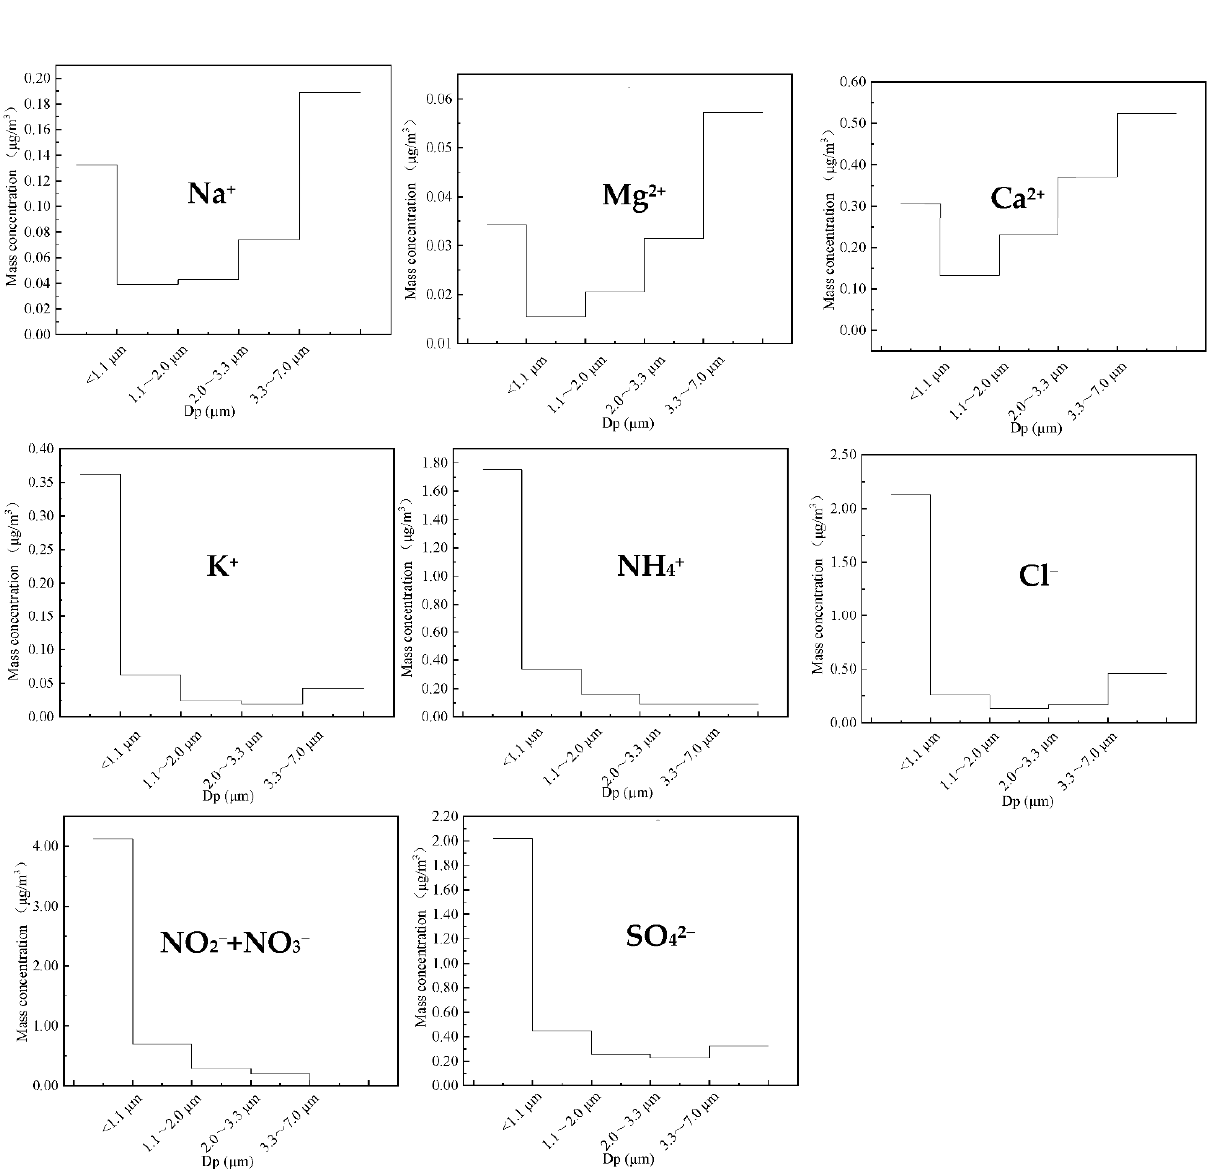
Figure 3. Size distribution of water - soluble inorganic ionic species.